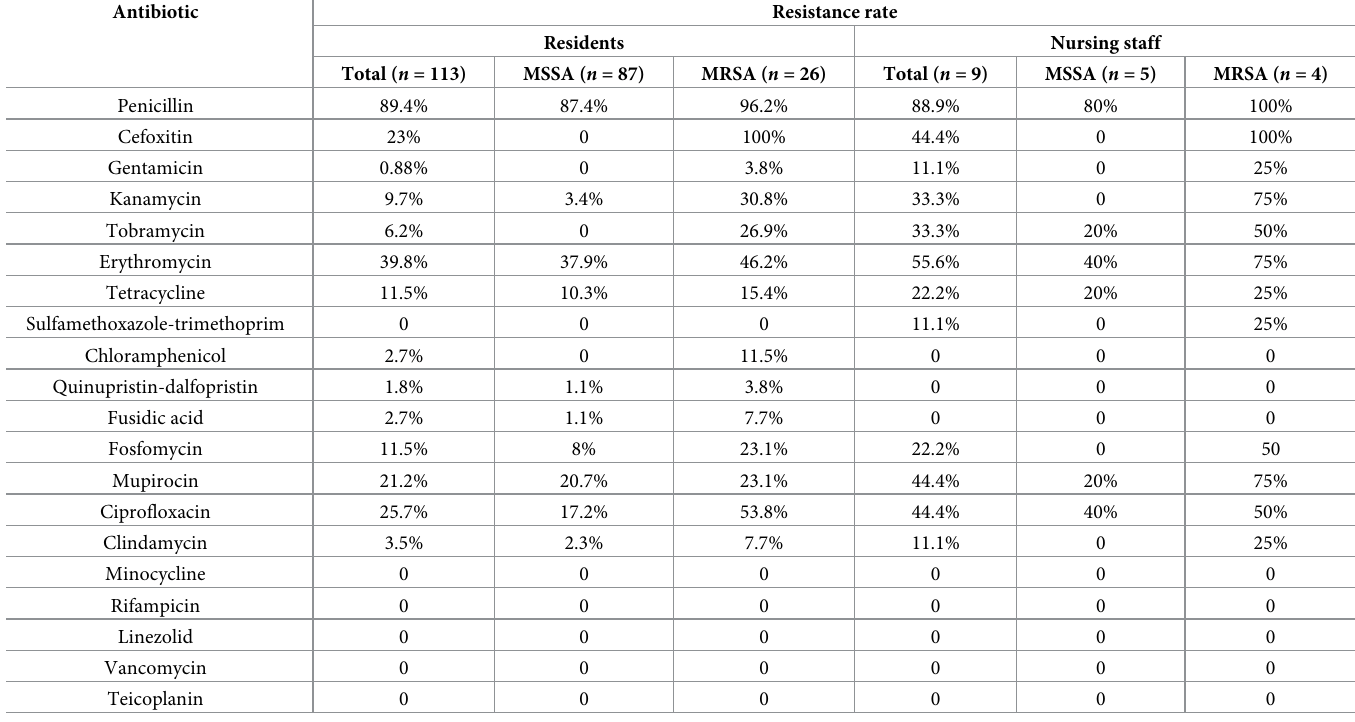
Table 2. The antimicrobial resistance rates of Staphylococcus aureus isolates obtained from residents and nursing staff in three nursing homes in Shanghai.